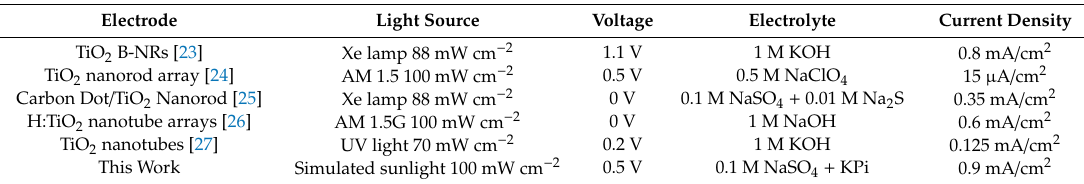
Table 2. Statistical list of references.